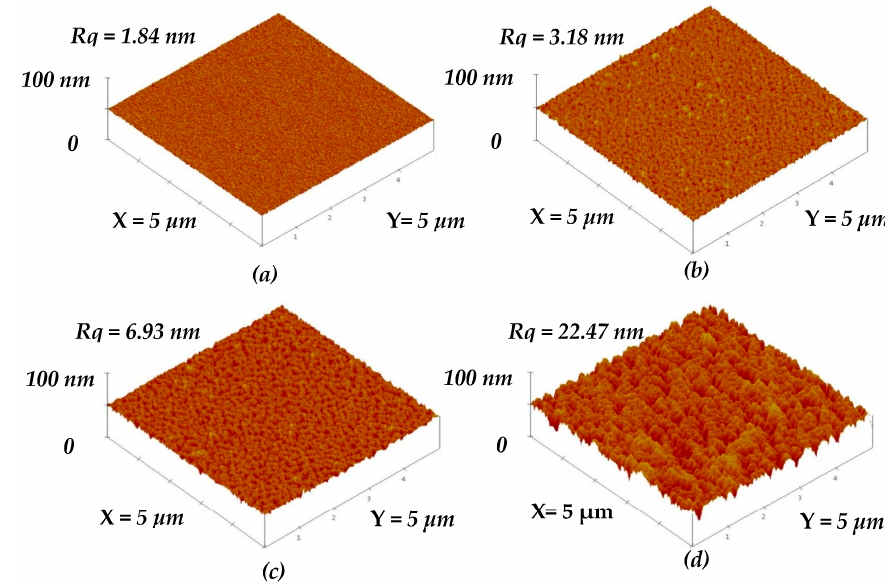
Figure 2. Surface roughness of the ( a ) un-treated a-TiO x film; and SFE-treated a-TiO x film for ( b ) 10; ( c ) 20; and ( d ) 35 s; respectively.